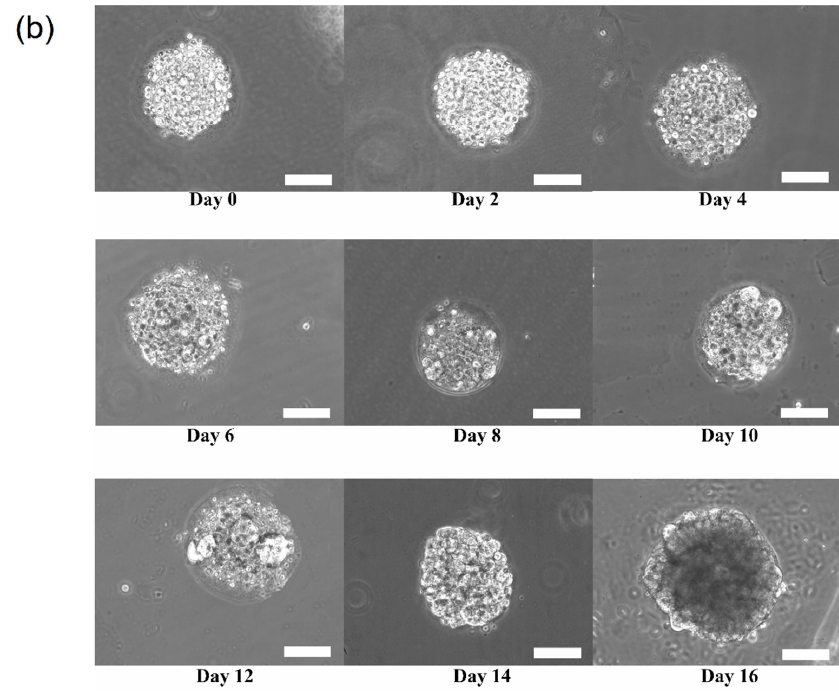
Figure 3. Phase contrast microscopic image of calcium alginate encapsulated ( a ) Three-dimensional (3D) human keratinocytes (HaCaT) and ( b ) oral squamous cell carcinoma (OSCC) cell line (ORL-48) growth for 16 days of culture at 100× magnification (Scale bar: 100 μ m).